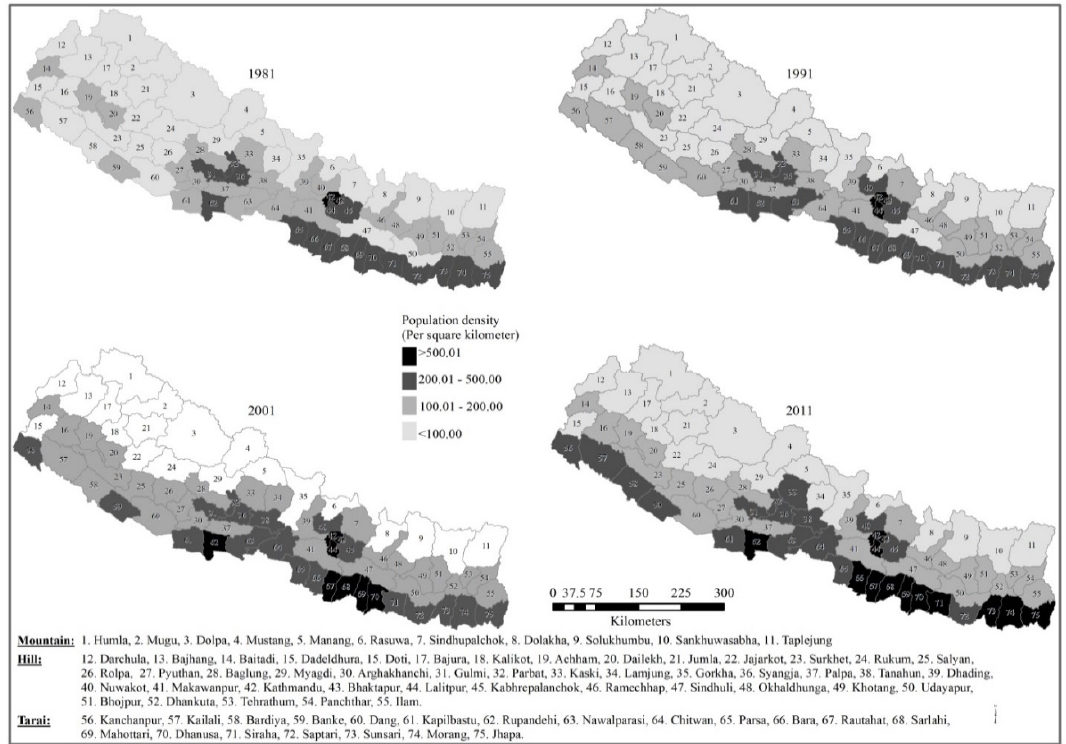
Figure 4. Population concentration at the lower elevation (1980–2011). Figure 5. Population concentration at the lower elevation